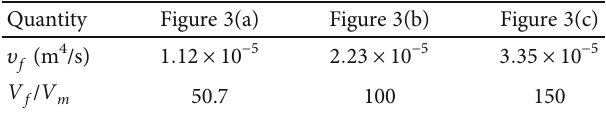
Figure 3: Pressure contours (in Pa) for a naturally fractured reservoir and a single natural fracture with a strength of (a) 1 : 12 × 10 − 5 , (b) 2 : 23 × 10 − 5 , and (c) 3 : 35 × 10 − 5 m 4 /s . The e ff ective far- fi eld velocity is 1 : 12 × 10 − 6 m/s from left to right. Table 2: Inputs for the sensitivity of natural fracture strength.